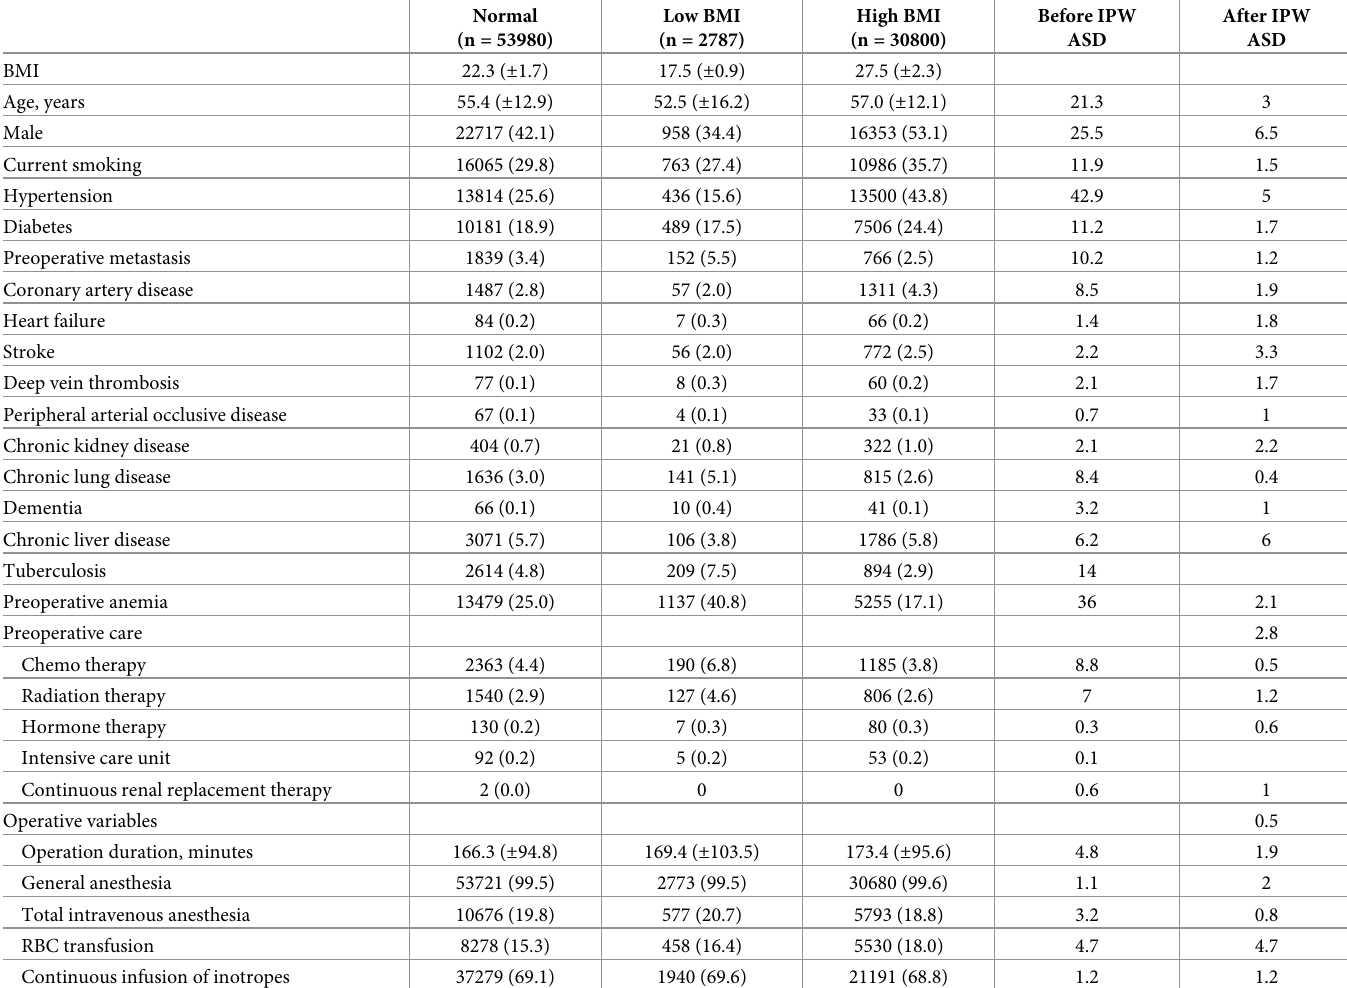
Table 1. Baseline characteristics according to preoperative body mass